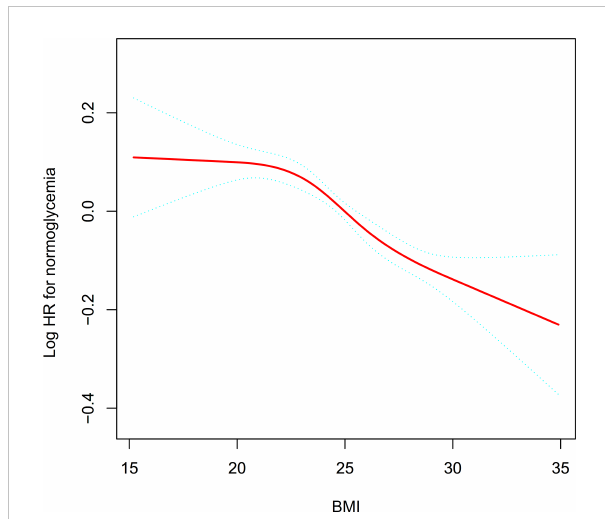
FIGURE 6 The nonlinear relationship between BMI and reversion to normoglycemia in patients with IFG. The result showed that the relationship between BMI and reversion to normoglycemia from IFG was nonlinear, with the in fl ection point of BMI being 21.7kg/m 2 .